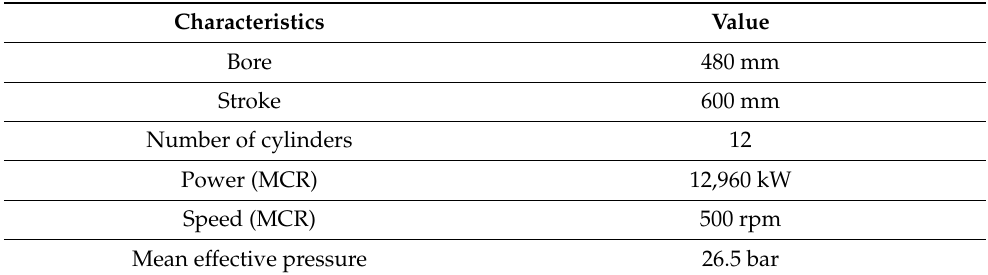
shaft, 3—gearbox, 4—four-stroke diesel engine).